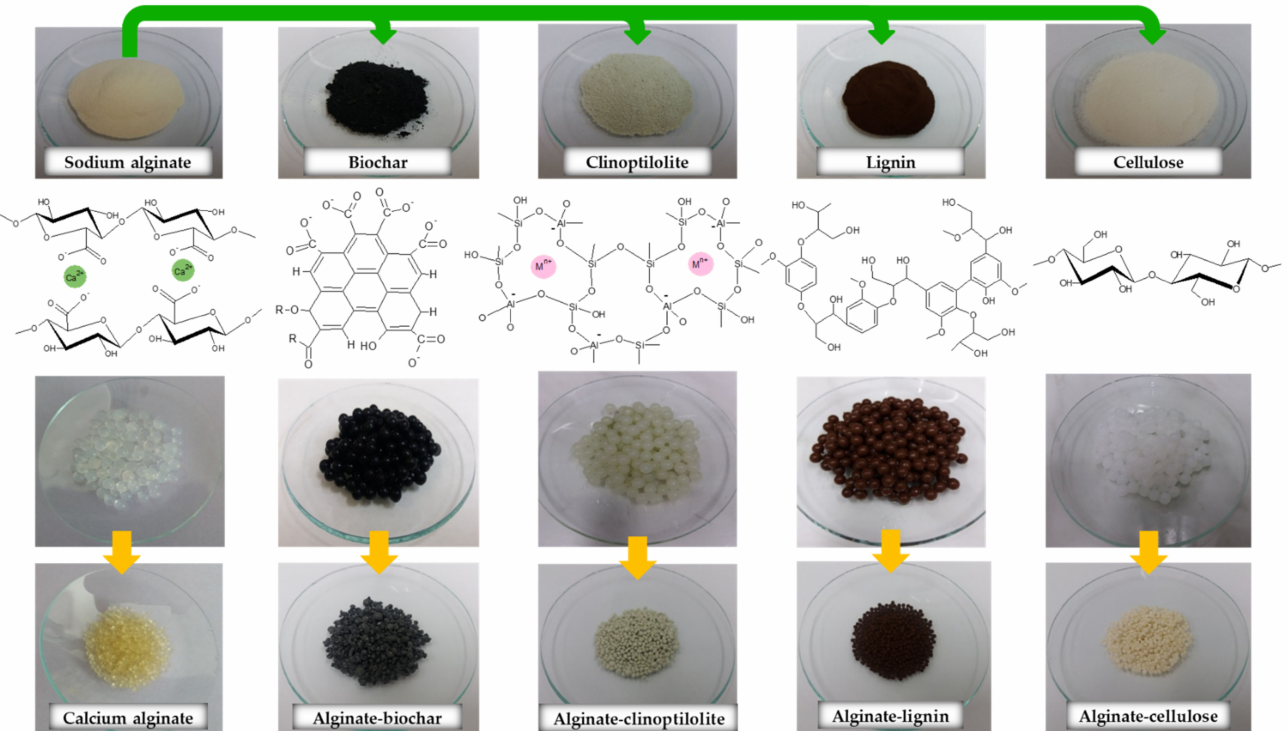
Figure 2. Images of the obtained calcium alginate and alginate-based